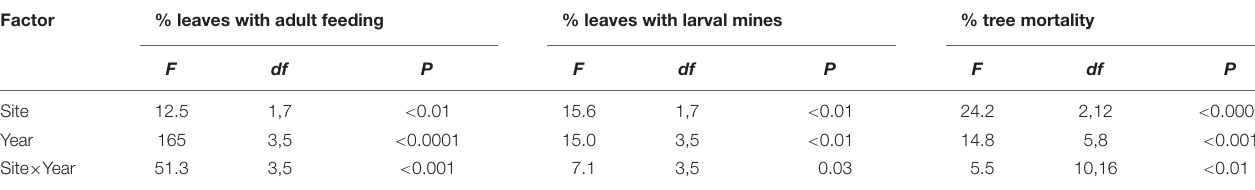
TABLE 2 | Results of multivariate ANOVA (SAS GLM for repeated measures) testing the effect of site, year, and site × year interaction on the percentages of American beech: (1) leaves damaged by Orchestes fagi adult feeding; (2) leaves mined by O. fagi larvae; and (3) trees that were dead, in Nova Scotia, Canada. Factor % leaves with adult feeding % leaves with larval mines % tree mortality